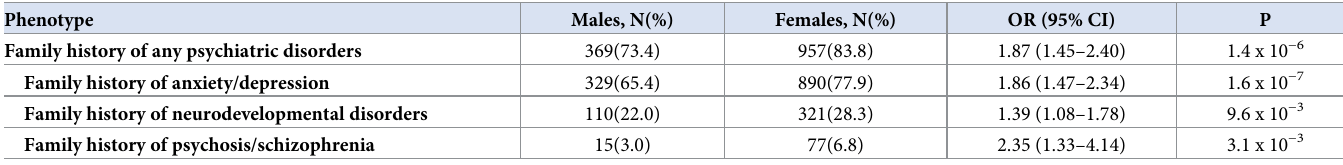
Table 1. Family history of psychiatric disorders of males and females with anxiety and depression in NCMH.